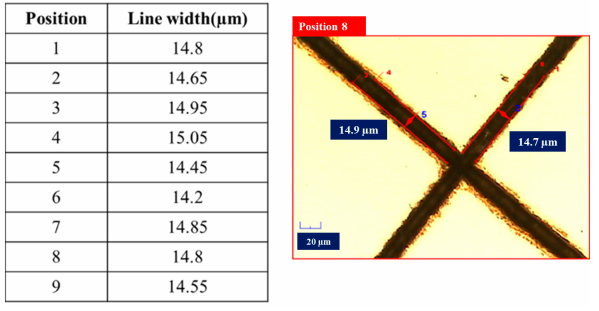
Figure 5. 9 points measurement and picture of gravure plate.